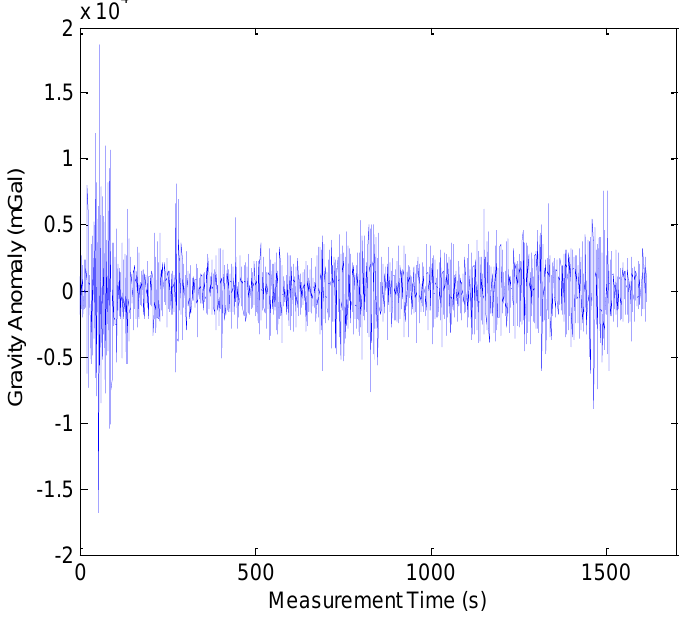
Figure 4. Gravity anomaly before low-pass filtering.